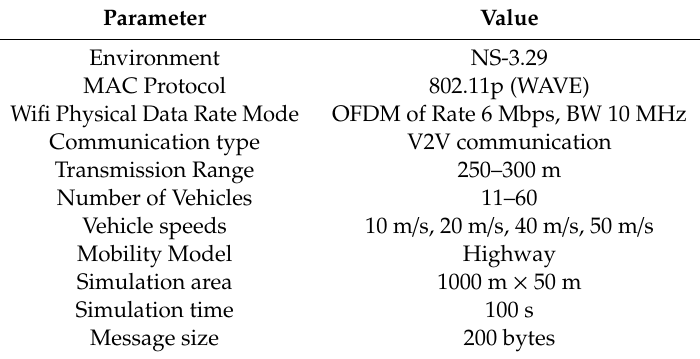
Table 7. Simulation parameters.